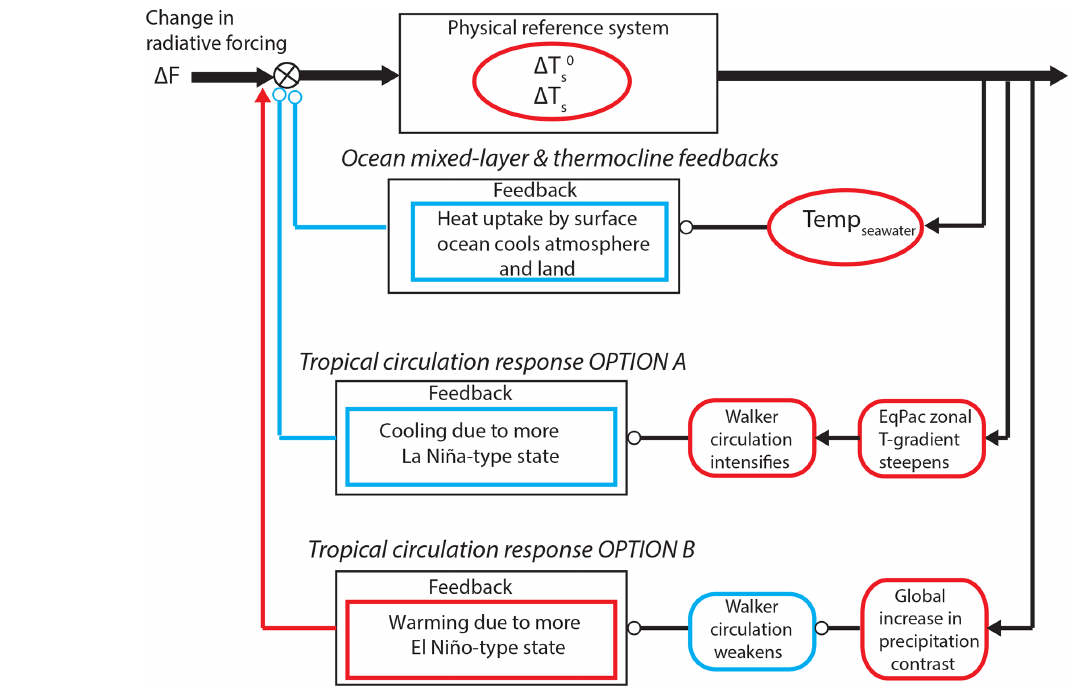
Figure 8. Schematic of important fast ocean feedbacks. The sign of the tropical circulation feedback has not been clarified yet. Arrows indicate positive coupling; open circles indicate negative coupling. Changes in state variables are indicated by ellipses, changes in processes by rounded rectangles. Red indicates increasing values of variables, strengthening of processes, or positive feedbacks; blue indicates the opposite. The change in surface air temperature (cid:49)T s in the presence of feedback is different from the change (cid:49)T 0 s without